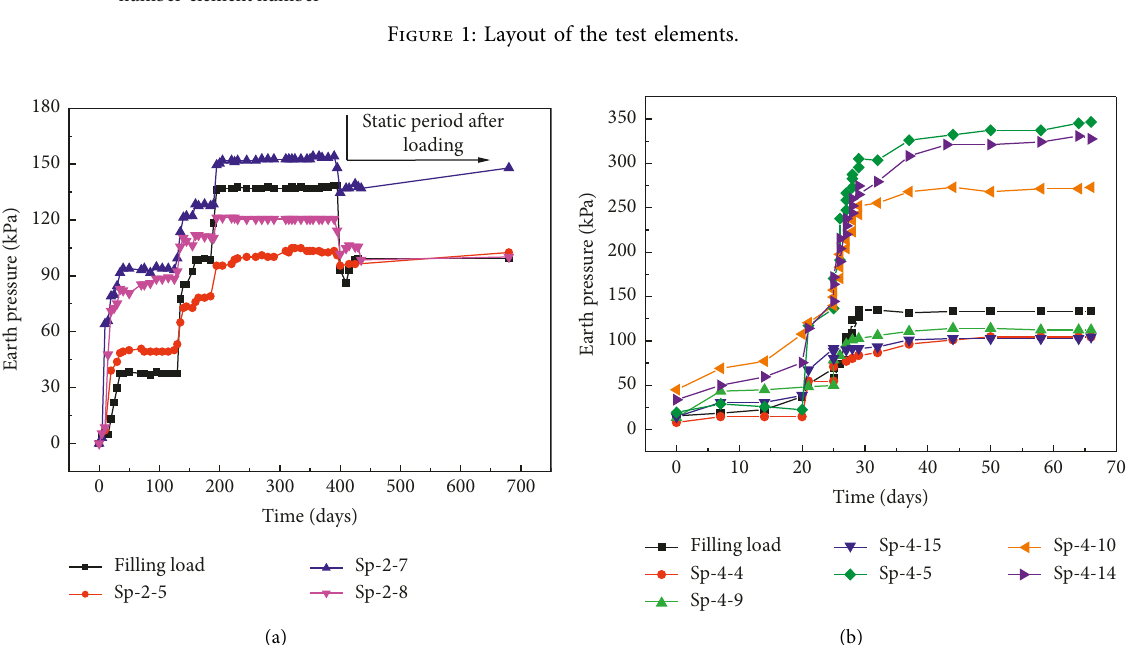
Figure 1: Layout of the test elements.